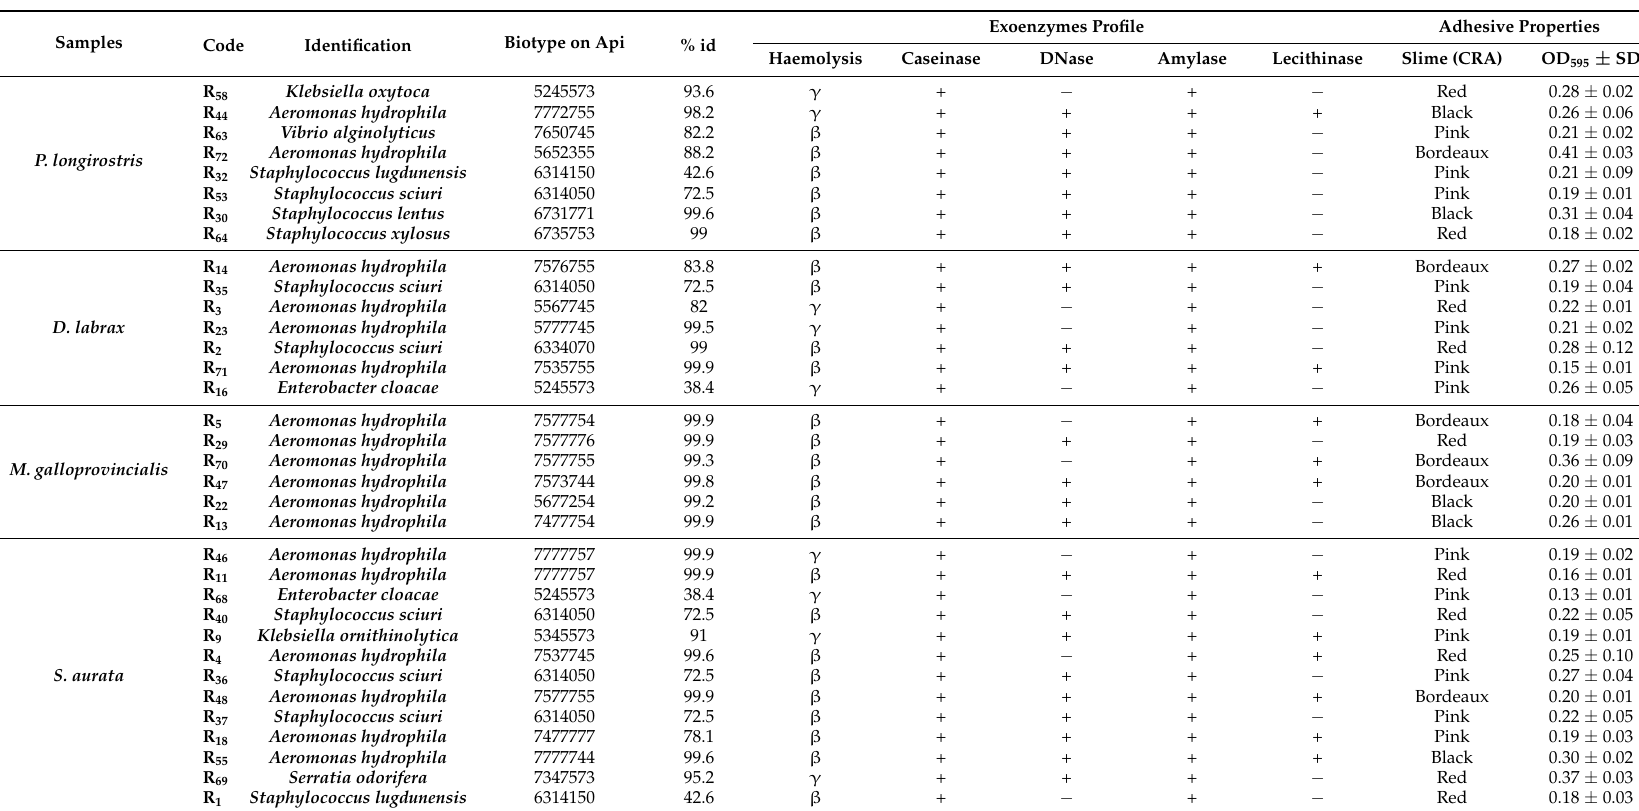
Table 1. Biotypes obtained on Api strips, exoenzymes profile and adhesive properties of the 34 strains isolated from fish and shellfish products. ( − ): Negative; (+):